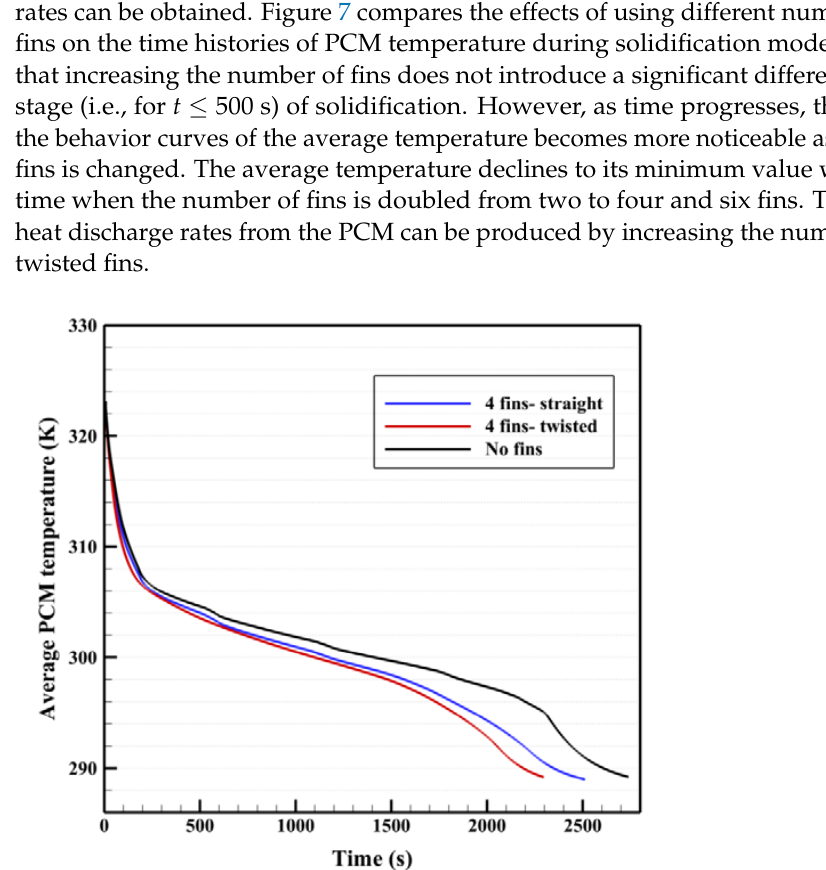
Figure 6. Time history of average temperature for the cases of no fins, straight fins, and twisted fins.